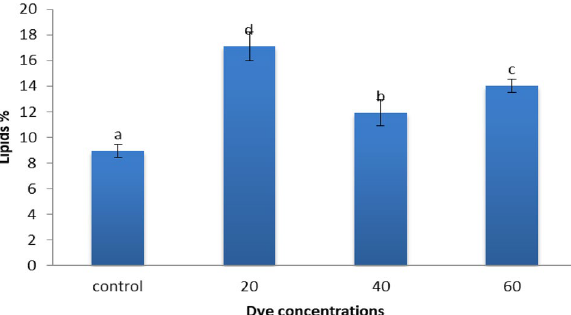
Figure 8. Effect of different dye concentrations (Disperse orange 2RL) on lipids percentage produced by microgreen alga S. obliquus, under mixotrophic conditions, pH 7 and KNO 3 1.5 g/L. Par represent standard error, different letters clear the significant result.